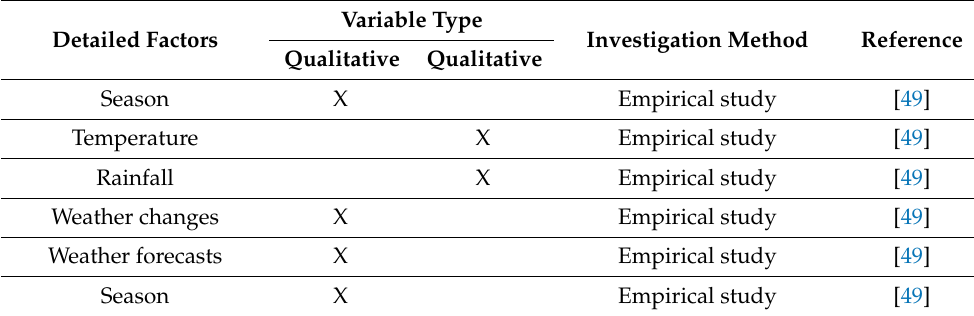
Table 14. Factors related to weather conditions.